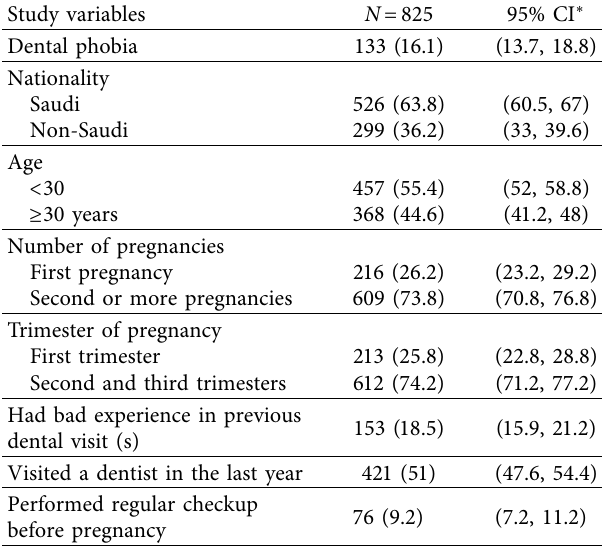
Table 1: Distribution of study variables among pregnant